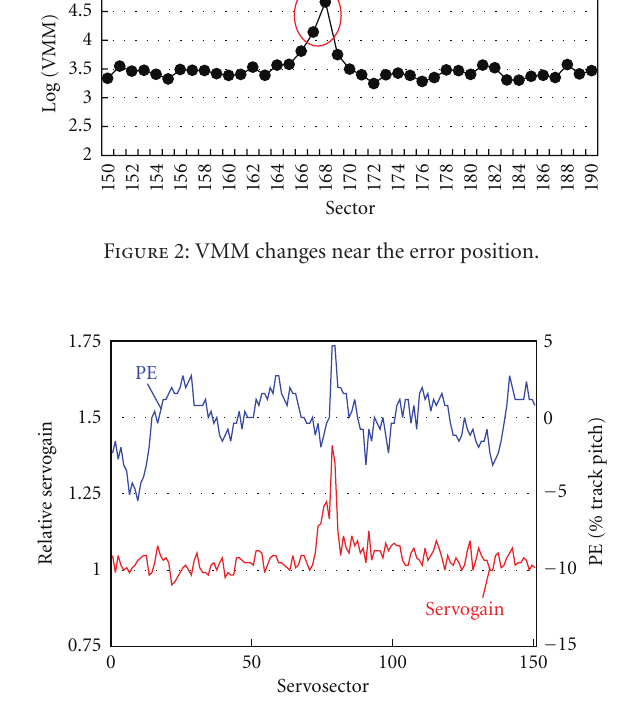
Figure 3: Relative servogain and position error (PE) changes when head may contact